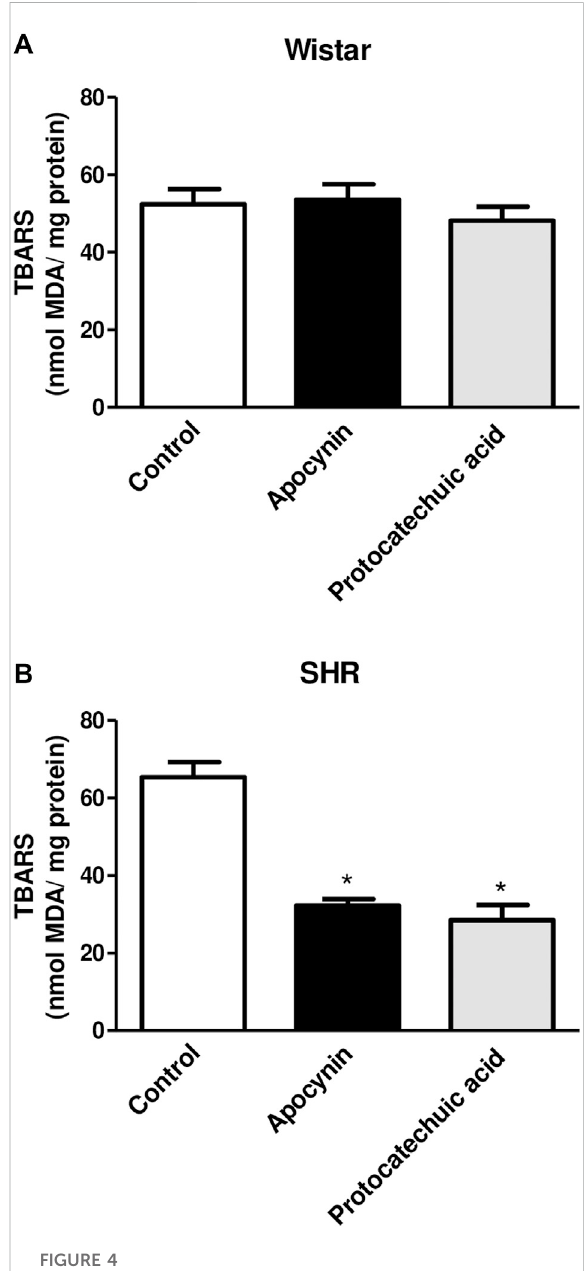
FIGURE 4 Determination of the percentage of thiobarbituric acid reactive substances (TBARS), in nmol MDA/mg protein, in aorta rings unstimulated (Control, white bars), or stimulated (100 μ mol/ L) with apocynin (black bars) or protocatechuic acid (grey bars)fromWistarrats (A) andSHR (B) .Valuesrepresentthemean± SEM of the results, n = 5 – 7. * p < 0.05 Apocynin and Protocatechuic acid vs. Control.